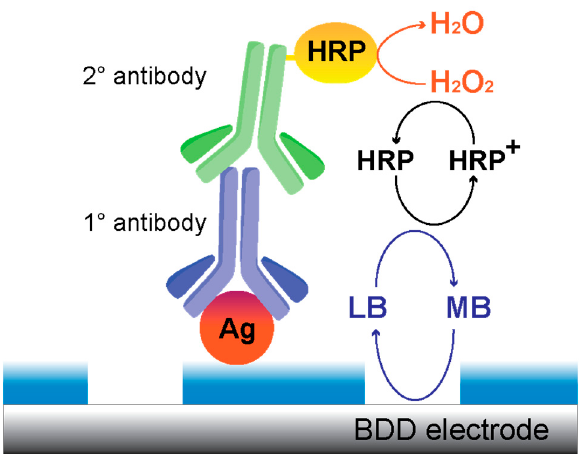
Figure 1. Schematic representation of the arrays of nanoelectrodes (NEA)-gliadin. The polycarbonate (PC) surface is exploited to immobilize the antigen (Ag) protein, gliadin. The assay is performed by molecular recognition of the target by the primary antibody anti-gliadin IgG and a subsequent secondary antibody anti-IgG labeled with horse radish peroxidase (HRP) enzyme. The electrocatalytic cycle was generated by adding the enzyme substrate H 2 O 2 and the mediator methylene blue (MB).